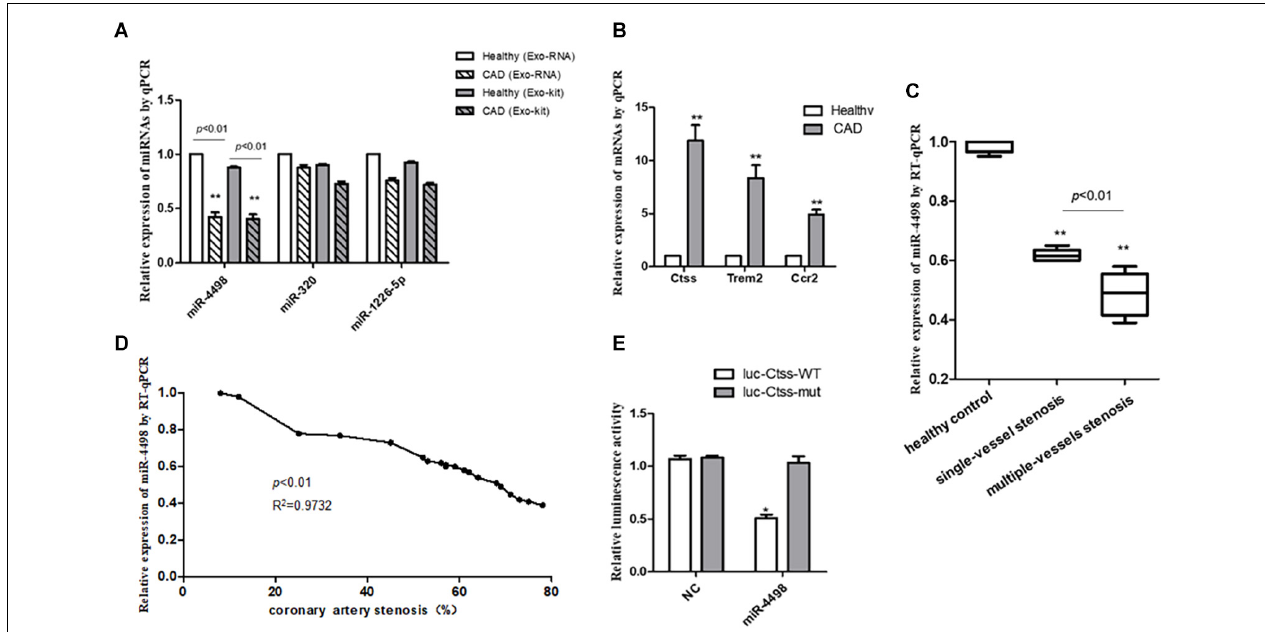
FIGURE 5 | The quantitation of RNAs to validate the predicted results. (A) The quantitation of miRNAs isolated from plasma exosomes directly with exoRNeasy Midi Kits or miRNAs in exosomes isolated with exoEasy Max Kit as detected by RT-PCR. ** p < 0.01 vs. healthy control, n = 3/group. (B) The quantitation of mRNAs in peripheral blood mononuclear cells was detected by RT-qPCR. ** p < 0.01 vs. healthy control, n = 3/group. (C) The comparison of levels of mir-4498 between the patients with single-vessel stenosis ( n = 6) and those with multiple-vessel stenosis ( n = 9) vs. healthy controls ( n = 5). ** p < 0.01 vs. controls. (D) The correlation analysis between the levels of miR-4498 and the percentage of coronary artery stenosis in patients. n = 20. (E) The luciferase reporter assays in THP1 cells transfected with wild-type or mutant miR-4498 luciferase vector and control. * p < 0.05 vs. normal control, n =